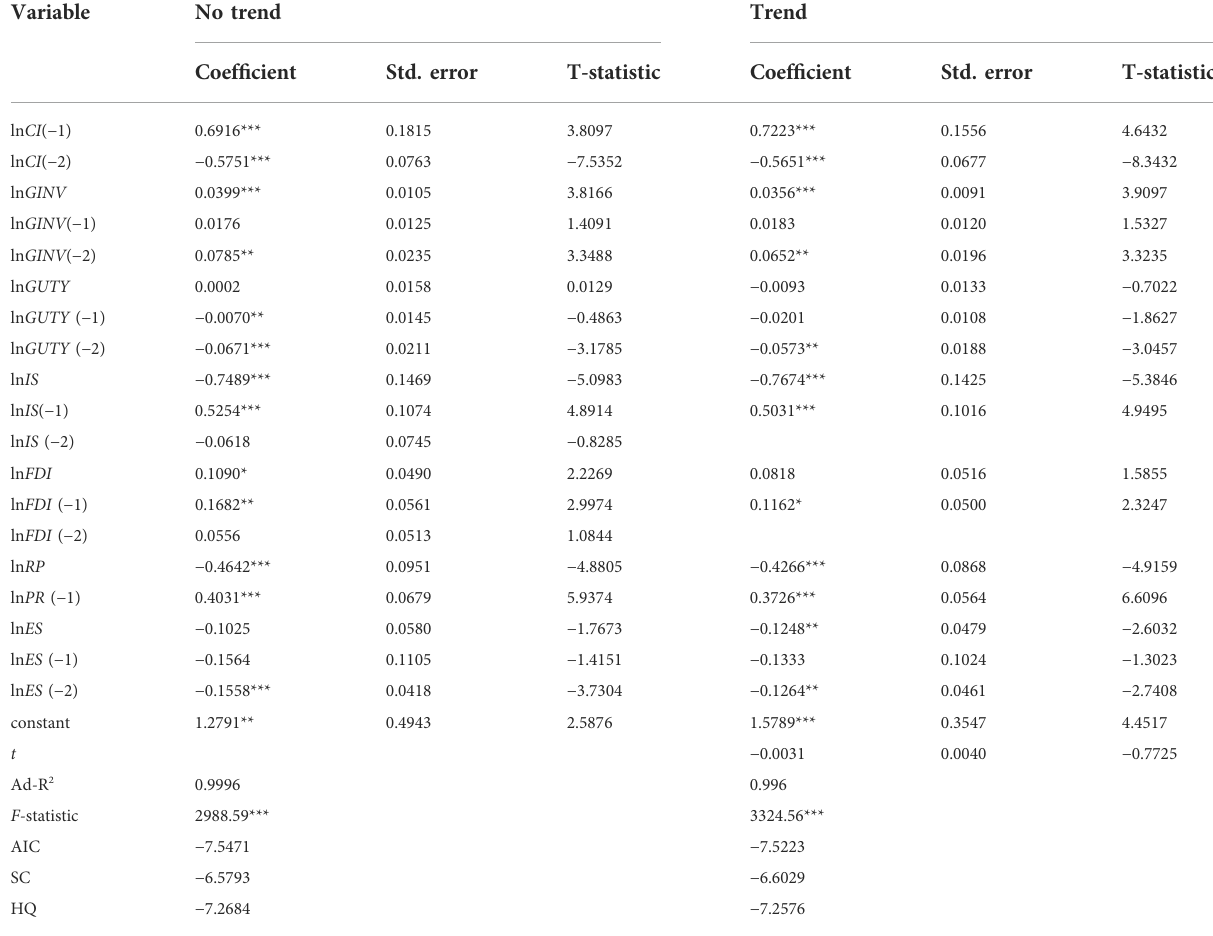
TABLE 2 ARDL model estimation